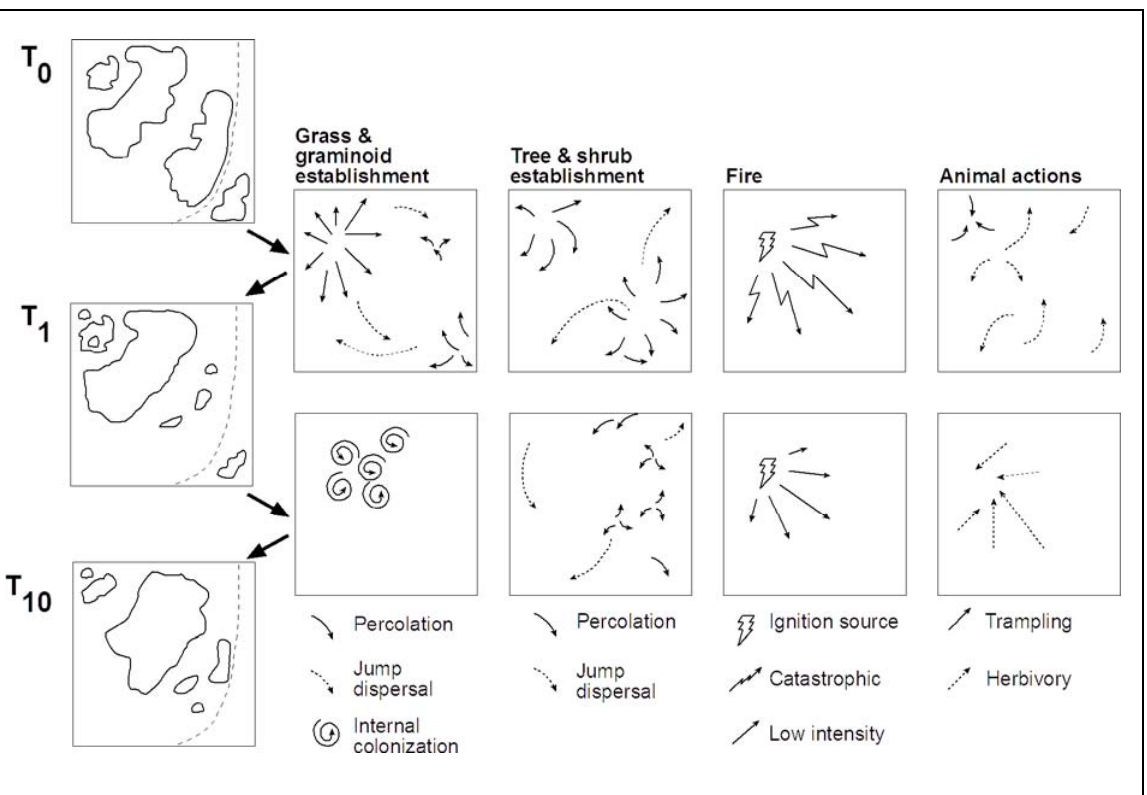
Figure 1. Stylized Socio-ecological Savanna System Contingencies: Presented here are spatial processes effecting change in a hypothetical landscape with a grassland-woodland mosaic with two underlying soil types (their border represented by the dashed line). These change agents include vegetation ecology processes and those associated with disturbances caused by fires and large herbivores. Shown also are temporal contingencies, including historical legacies such as where forest patches were located in the past, with resulting spatio-temporal change over several time